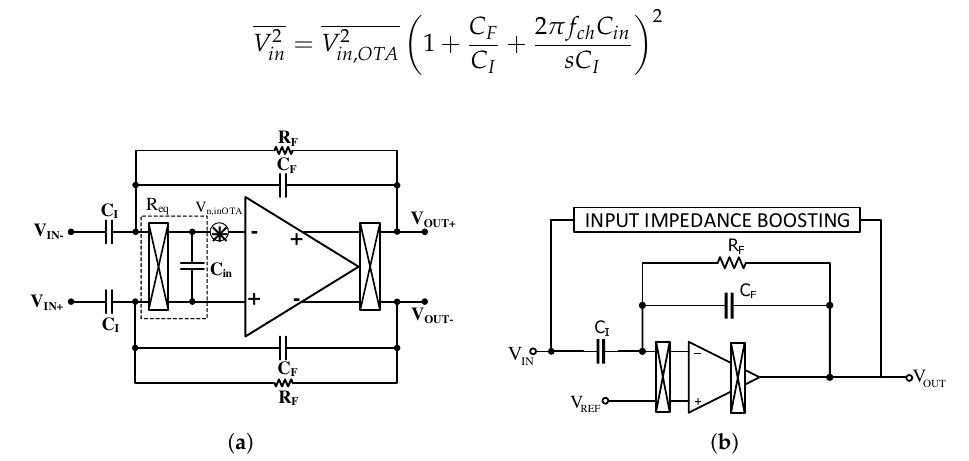
Figure 7. Chopper stabilization (CHS) technique in the CFN neural amplifiers. ( a ) Noise model of a neural amplifier when the first chopper is placed in front of the OTA; ( b ) Utilizing an impedance boosting feedback circuit to increase the amplifier input